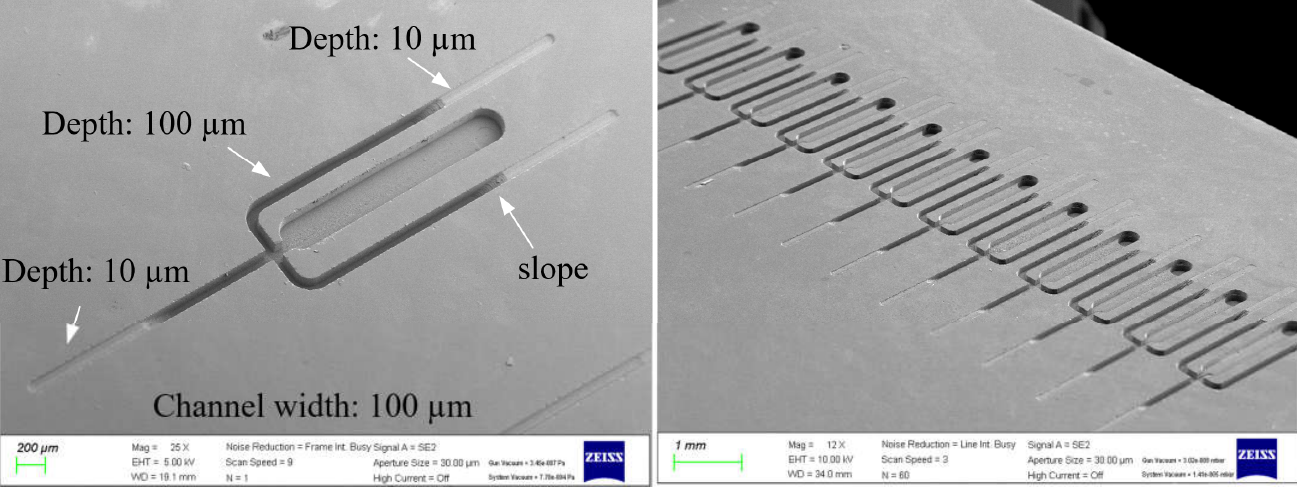
Figure 14. SEM images of microfluidic chip arrays with different channel depths (tool diameter: 100 µm; feed rate: 150 µm/s; channel depths: 10 and 100 µm).